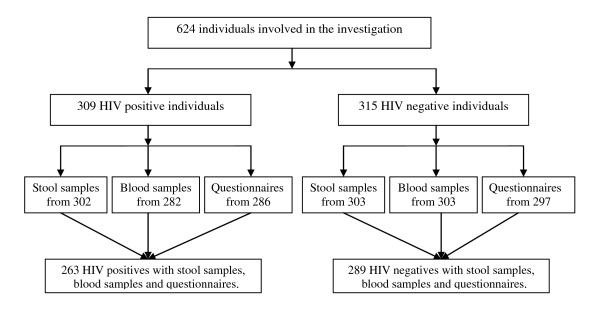
Participation in a survey on co-infections of HIV and intestinal parasites in a rural area of Fuyang city, Anhui province, People's Republic of China.